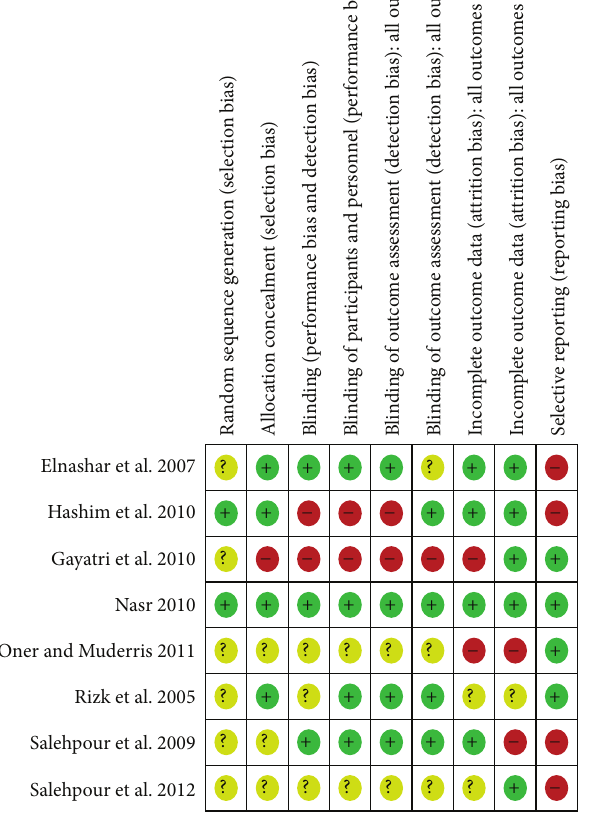
Figure 2: Cochrane risk of bias rool summary for included studies.